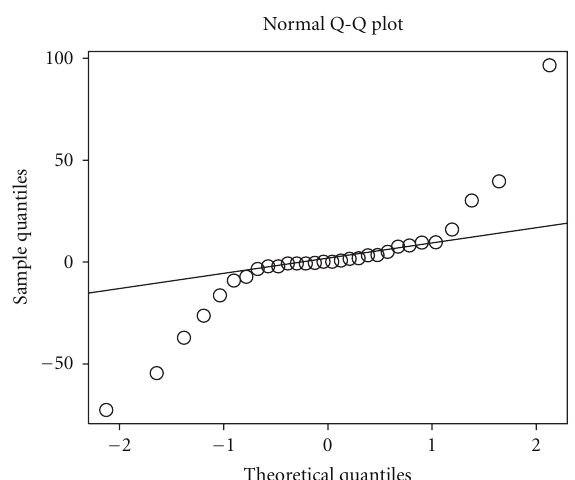
Figure 2: Normal Q-Q Plot: comparing research data to a standard normal population.